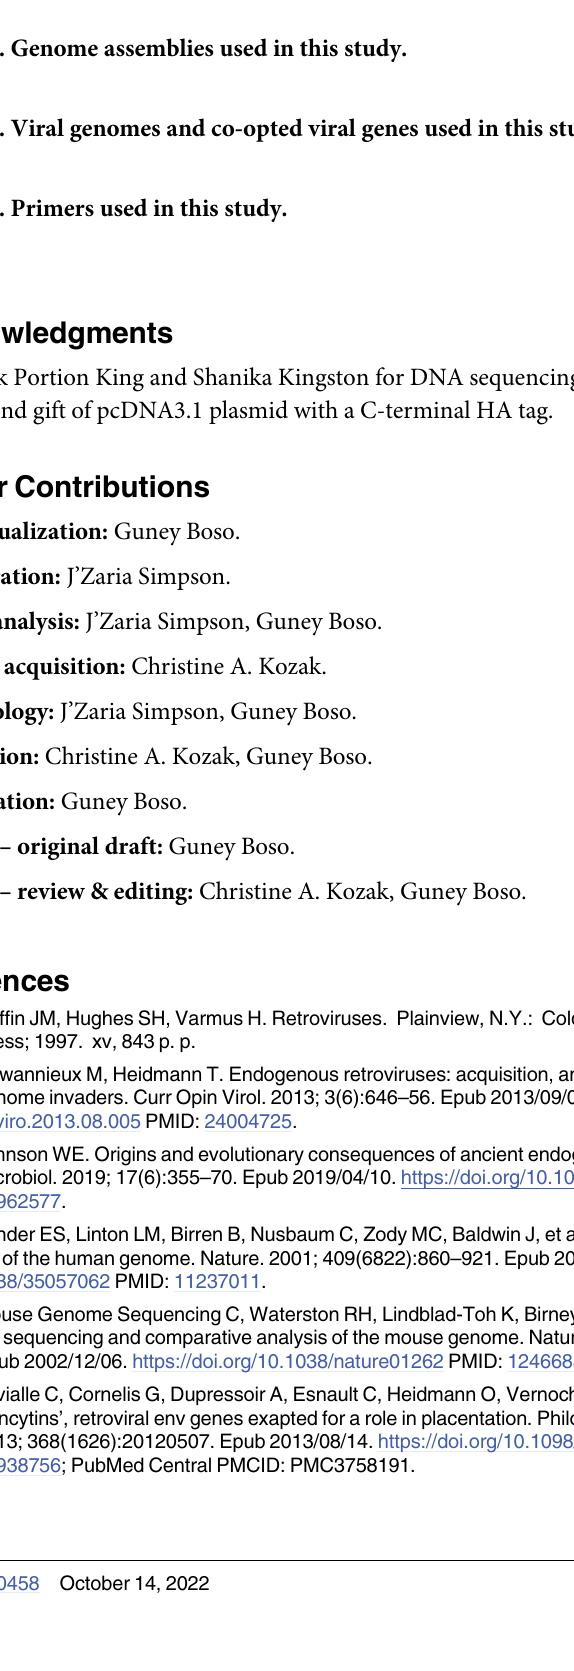
indicated species obtained via RACE-PCR is shown in the lower panel. Locations of the splice donor and acceptor sites, predicted poly A signal and T rich regions that follow the end of the transcripts are indicated.